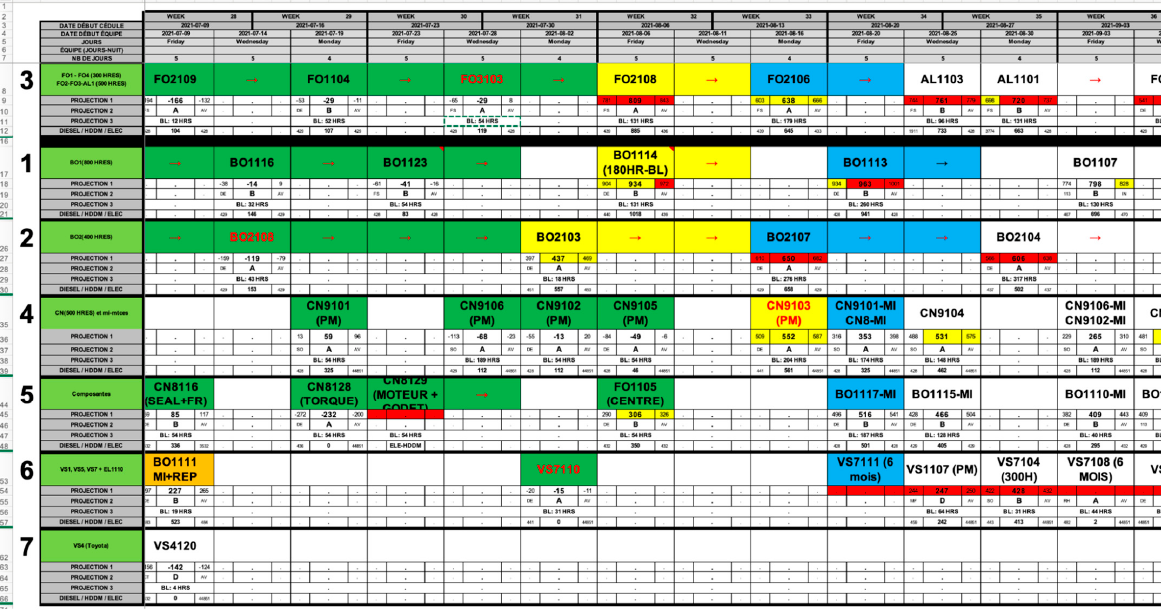
Figure B1. Excel schedule. Figure A1. Excel